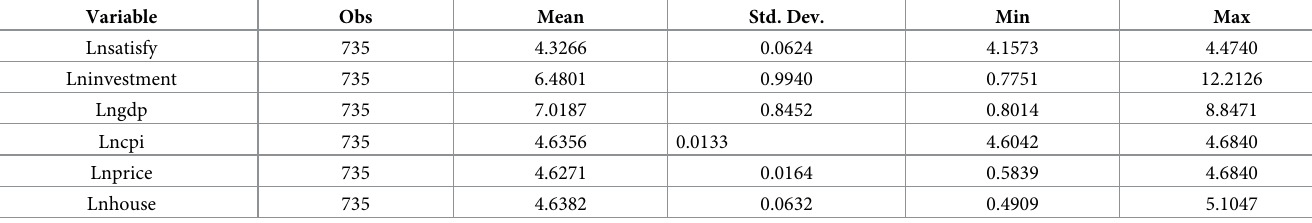
Table 1. Descriptive statistics of the